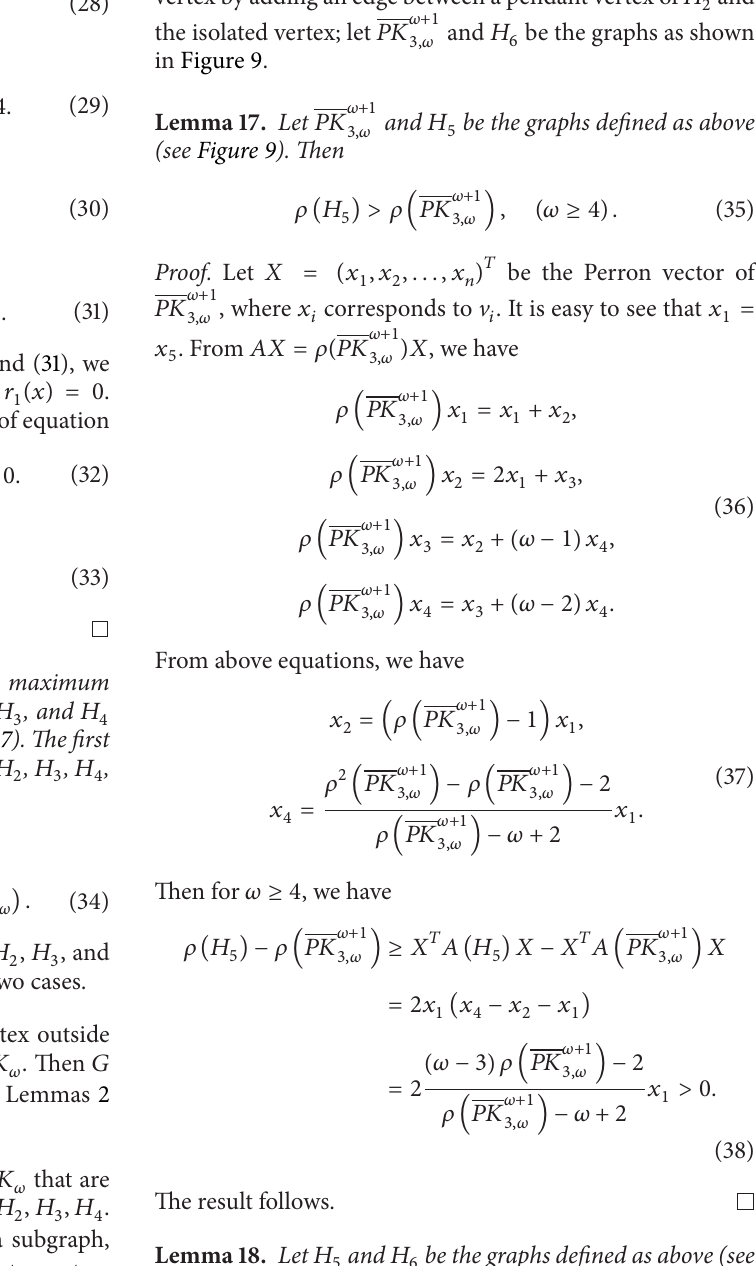
𝜔+1 𝐻 5 , and 3,𝜔 ,